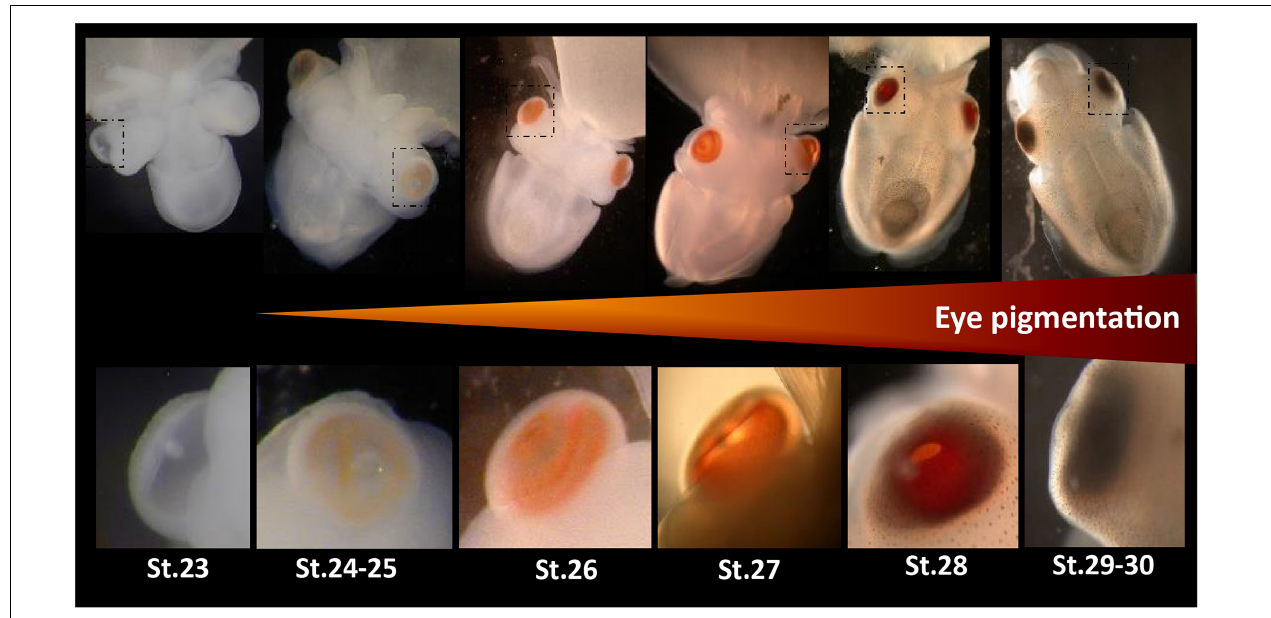
FIGURE 1 | Eye development in Sepia embryos. 30 developmental stages of Sepia officinalis are described (Boletzky et al., 2016). Top: full embryos, bottom: magnification of the eyes. Eye pigmentation starts at stage 24–25 (light orange) then darkens until reaching a dark brown color at the time of